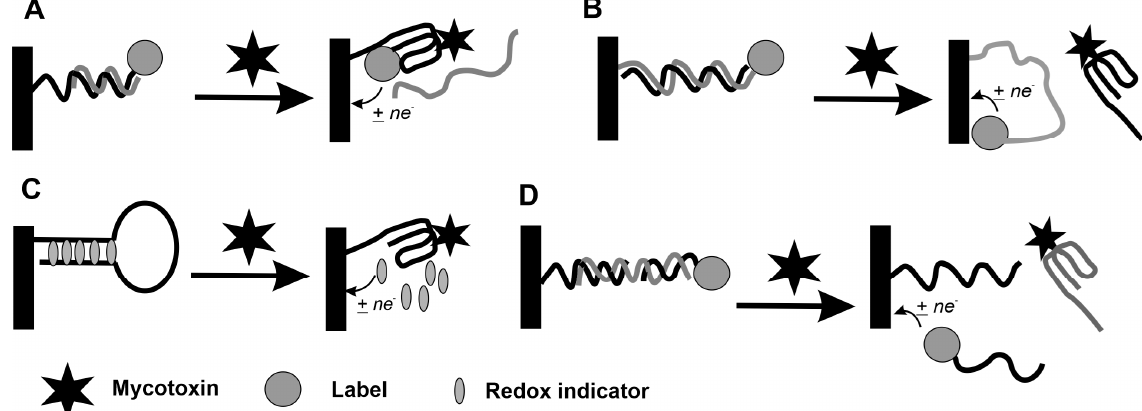
Figure 7. Schematic outlines of the signal generation modes in electrochemical aptasensors. ( A )–aptamer is attached to the electrode. Its folding releases auxiliary DNA and makes the distance of electron transfer narrower; ( B )–Auxiliary DNA is labeled and forms double-stranded helix with aptamer. Target reaction removes the aptamer and accelerates the electron transfer from the terminal label; ( C )–pinhole aptamer is saturated with redox active intercalator. Target reaction releases intercalator from the stem of the aptamer; ( D )–aptamer binds together two auxiliary DNA sequences. Its removal by binding with analyte releases labeled fragment producing redox signal.